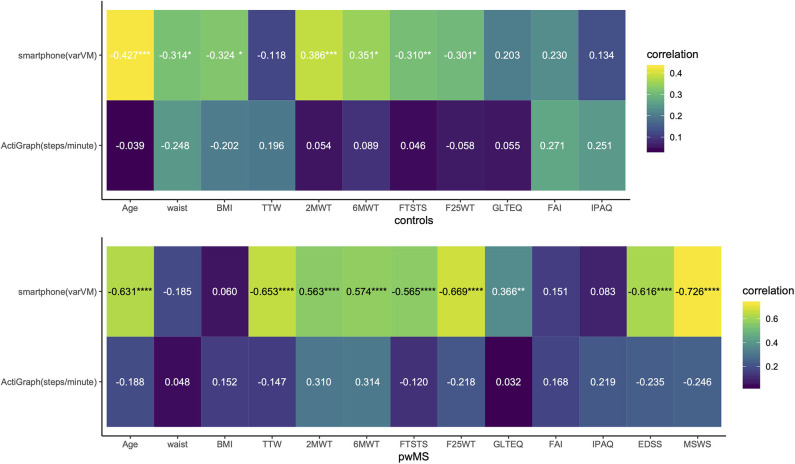
Association of clinical outcomes and questionnaires with smartphone varVM and ActiGraph steps/minute. Correlogram of Spearman rho; corrected p-values for multiple comparisons through FDR; *p < 0.05, **p < 0.01, ***p < 0.001, ****p < 0.0001.